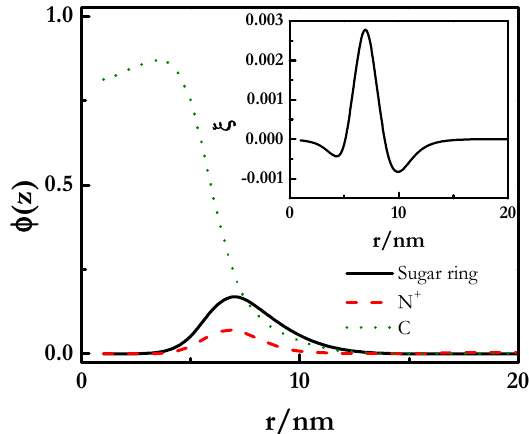
Figure 7. Radial volume fraction ( ϕ ( z )) profiles for the inner hydrophobic core and the charged corona of PDADMAC-APG complexes. The polyelectrolyte had a length of 100 segments and a segment valence of ν p = 1. The inset represents the dimensionless radial charge density ( ξ ) profiles for the complexes.